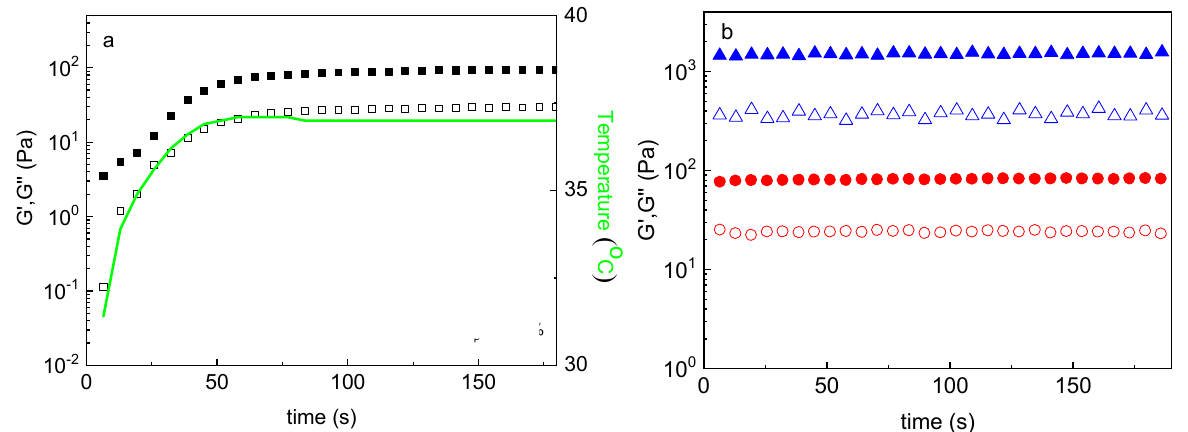
Figure 4. Storage G ′ (closed symbols) and loss G ″ (open symbols) moduli as a function of time ( a ) of the 5 wt% NaALG-g polymer aqueous solution without nanoparticles (the green line implies the progression of temperature from 25 °C to 37 °C) and ( b ) of the 7.5 wt% (triangles, blue) and of the 5 wt% (circles, red) graft copolymer solutions equilibrated at 37 °C.